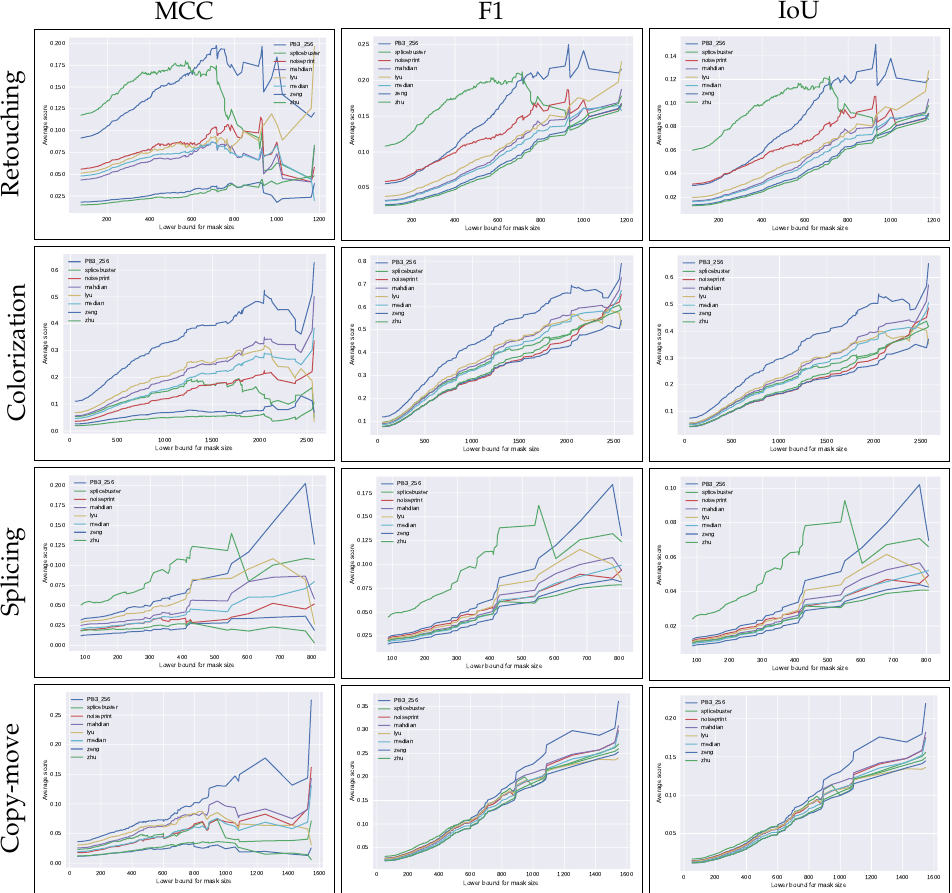
Figure 5. Average weighted MCC ( left ), IoU ( middle ) and F1 ( right ) scores obtained by each method as a function of the lower bound for the forgery size, in each of the datasets considered. Forgery size is shown as the square root of the mask size, which represents the side of its equivalent